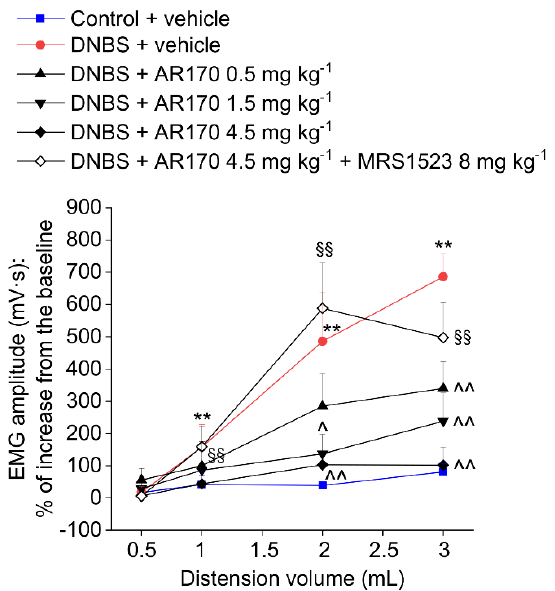
Figure 5. Visceromotor response (VMR) to the colorectal distension of DNBS treated animals after the acute administration of AR170 (0.5–4.5 mg/kg i.p.) both in the absence and the presence of the selective A 3 AR antagonist MRS1523 (8 mg/kg i.p., injected 15 min before AR170). Tests were performed 14 days after DNBS injection and 15 min after the acute administration of AR170. Control animals received the vehicle. Each value represents the mean ± S.E.M. ( n = 4). * p < 0.05 and ** p < 0.01 vs. the control + vehicle treated animals. ^ p < 0.05 and ^^ p < 0.01 vs. DNBS + vehicle treated animals. §§ p < 0.01 vs. DNBS + AR170 4.5 mg kg −1 treated animals.